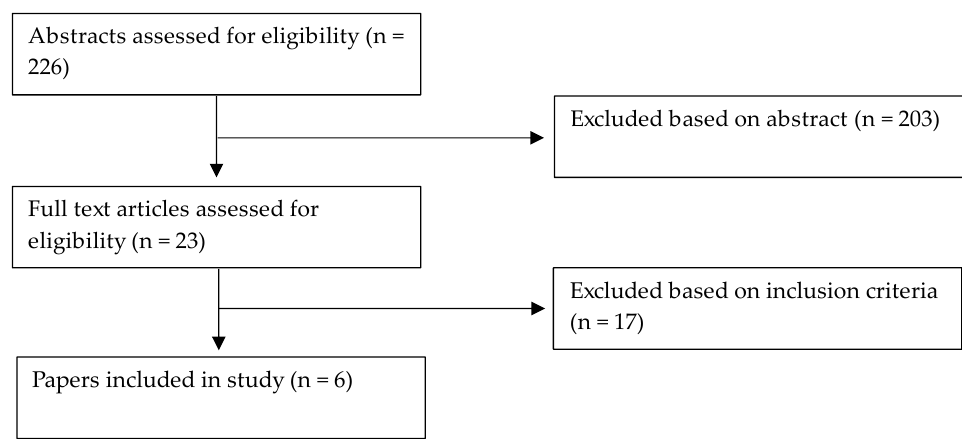
Figure 1. Consort Diagram of the Review Process.